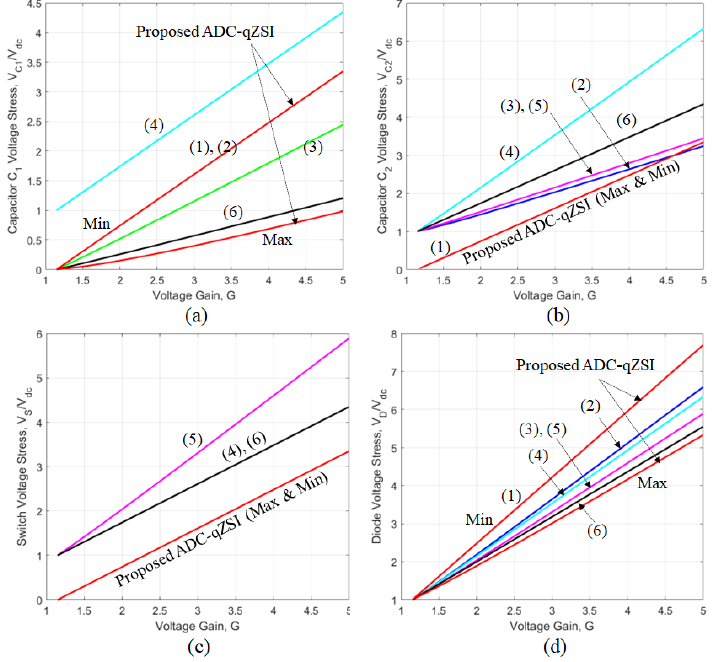
Figure 7. Comparison of component voltage rating: ( a , b ) voltage gain vs. capacitor voltage rating, ( c ) voltage gain vs. switch voltage rating, ( d ) voltage gain vs. diode voltage rating. (1) DqZSI [8], (2) SL-qZSI [18], (3) rSL-qZSI [19], (4) ASC-EqZSI [20], (5) ASC/SL-qZSI [21], (6) HG-qSBI [22].